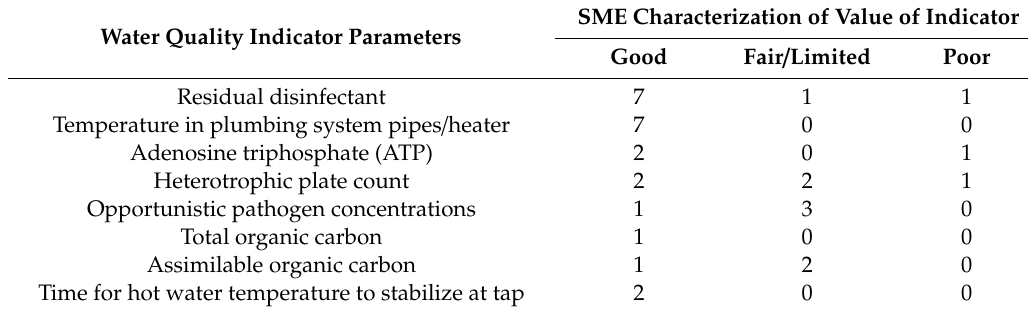
Table 5. SME identified indicators of water quality management in